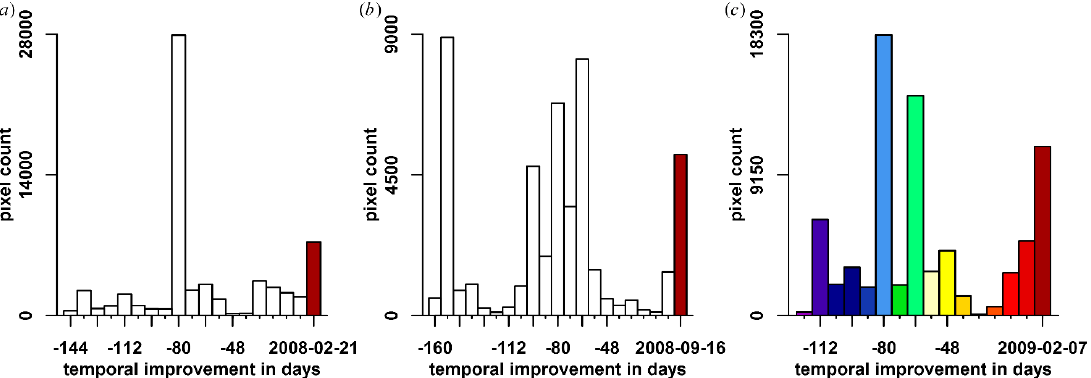
Figure 11. Improvement in disturbance timing using the hybrid detection. The improvement (in 8-day steps) is measured relative to the Landsat detection (dark red bar, i.e. , no improvement). The three slices that are characterized by the largest data gaps in the Landsat time series (see Figure 4) are shown in ( a – c ), respectively. The majority of the disturbances in ( c ) are attributed to only one disturbed area. This area is show in Figure 12; the same color-coding was